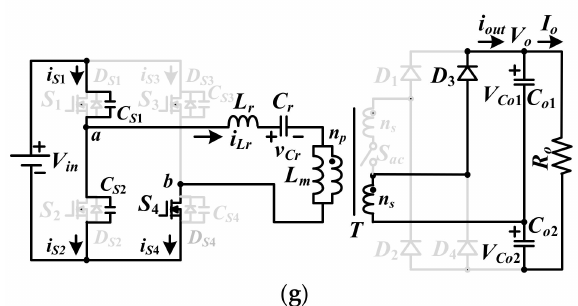
Figure 5. LLC converter at low high voltage region: ( a ) key PWM waveforms; ( b ) state 1 equivalent circuit; ( c ) state 2 equivalent circuit; ( d ) state 3 equivalent circuit; ( e ) state 4 equivalent circuit; ( f ) state 5 equivalent circuit; ( g ) state 6 equivalent circuit.